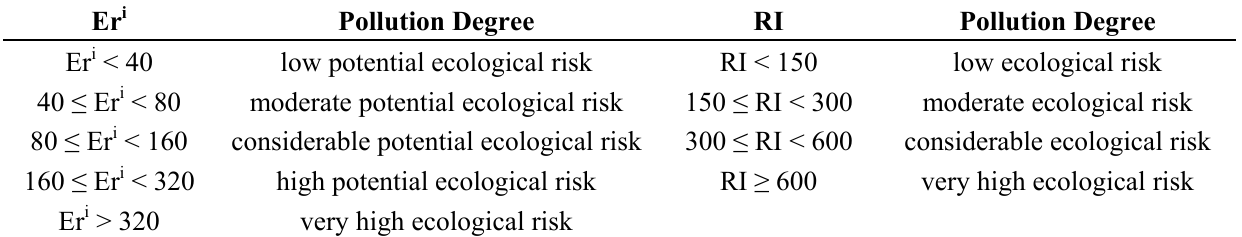
Table 1. The relationship of Er i , RI and pollution